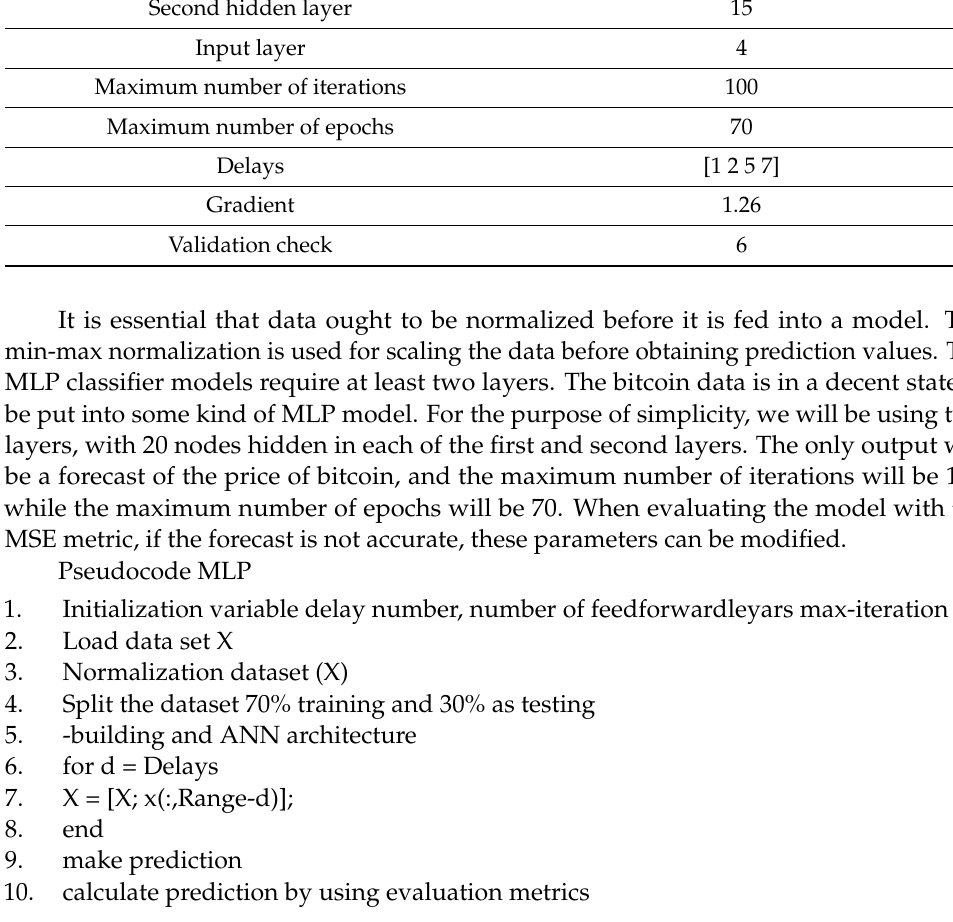
Figure 4. Structure of the MLP for predicting bitcoin prices.